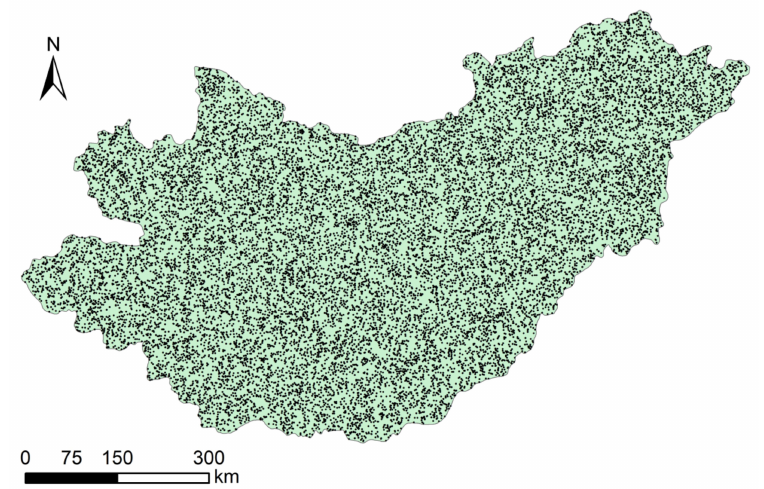
Figure 10. Random sampling